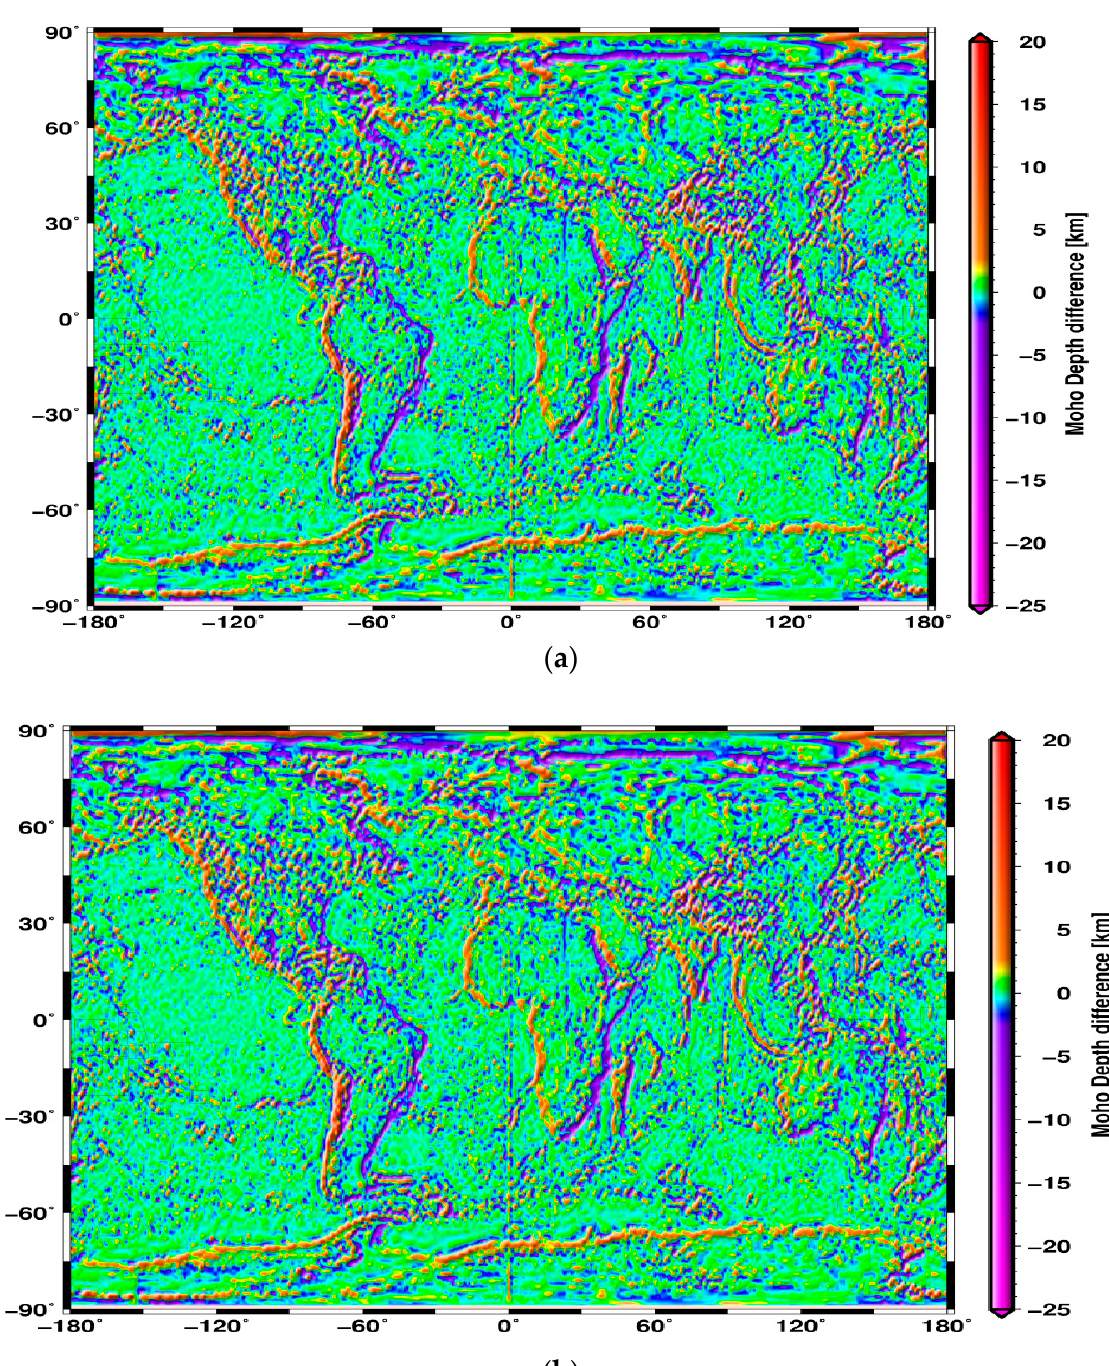
Figure A2. The Moho depth differences between the Eurasian [5] and European [29] models within Europe. Unit: km.